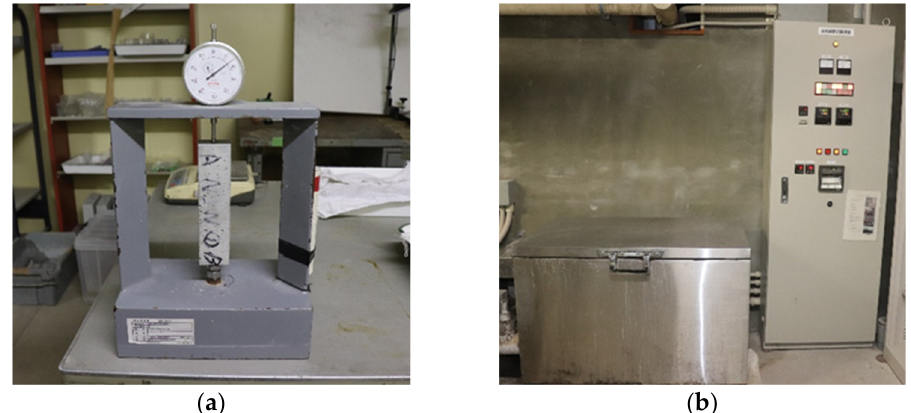
Figure 2. Photographs of the test equipment: ( a ) dial gauge used to measure length-change ratio of dry shrinkage test; ( b ) the test tank of freeze–thaw test.